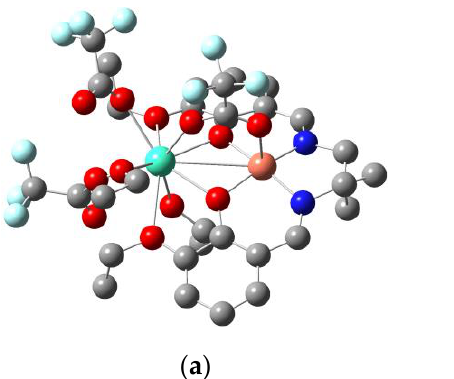
Mn(II) and Mo(III) and Mn(II) and Cr(III), respectively (Figure 11). For models A and B, the Operdew, OPBE, O3LYP and B3LYP functionals, while the antiferromagnetic exchange